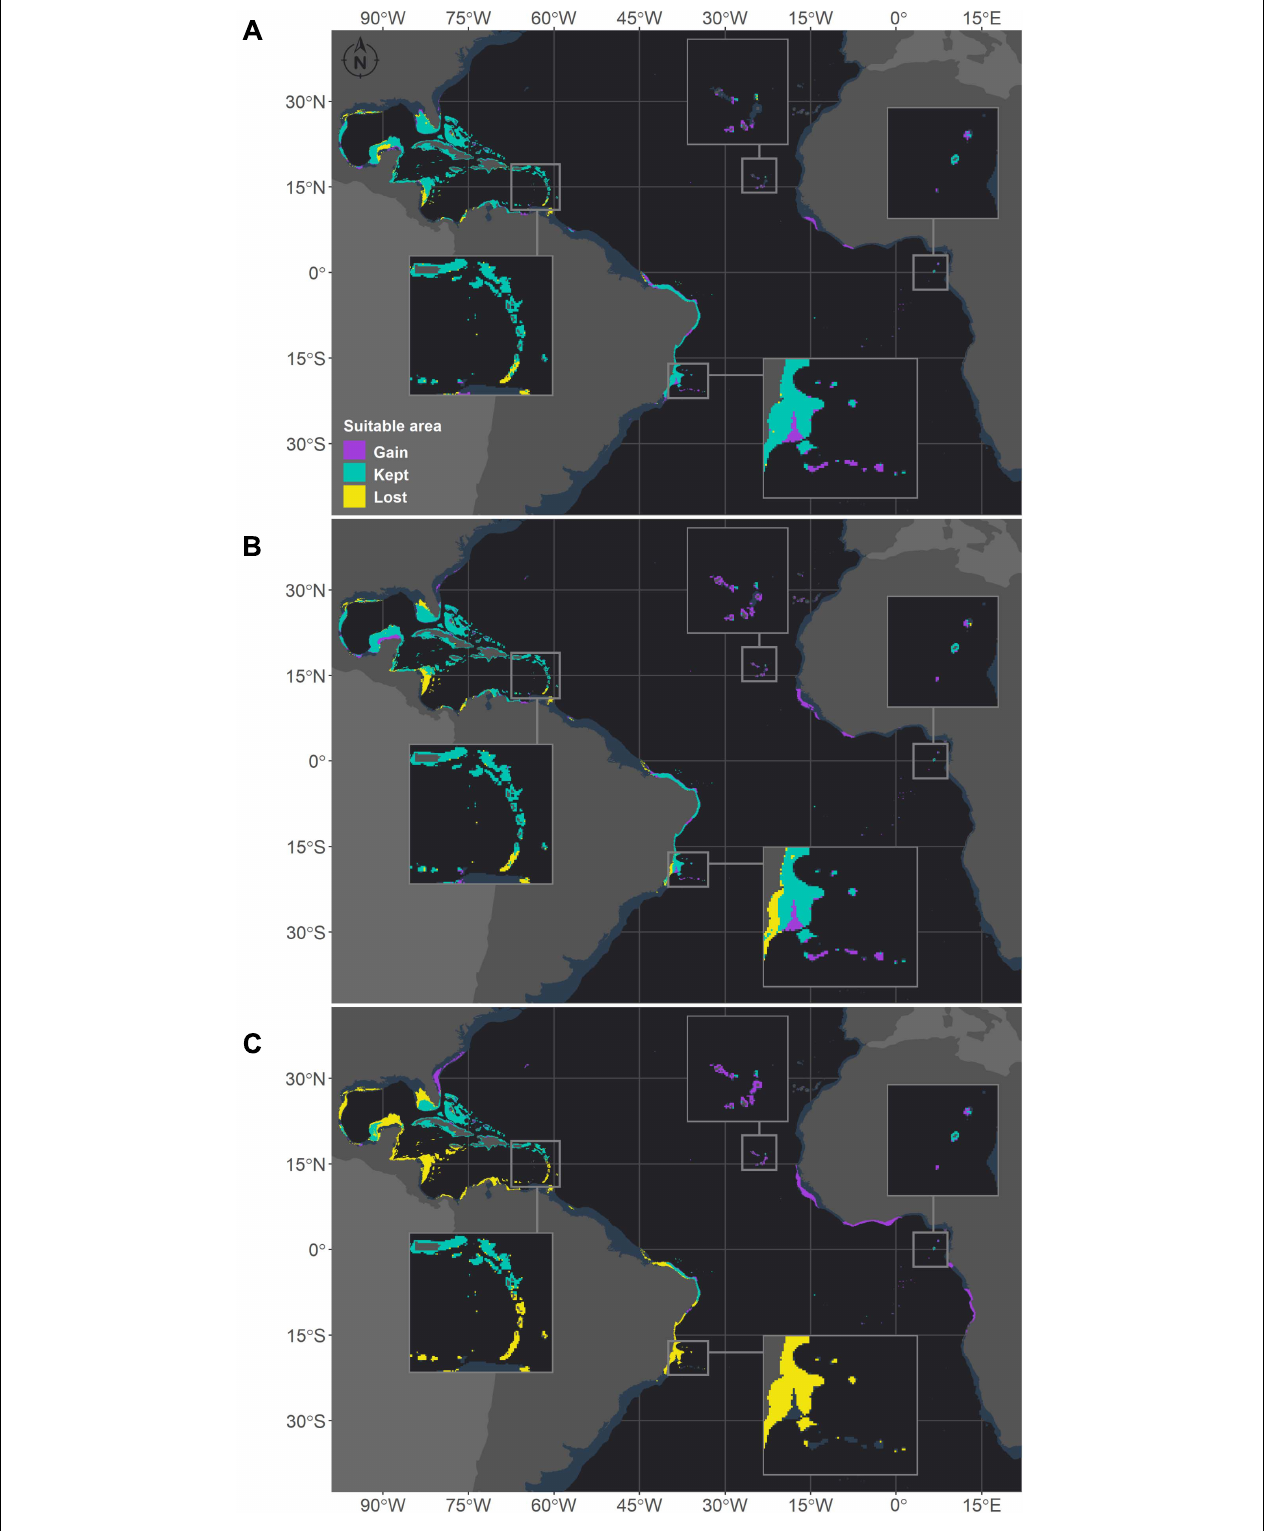
FIGURE 6 | Projected habitat suitability under future relative concentration pathway (RCP) scenarios for Siderastrea sp. in the Atlantic Ocean obtained through an ensemble modeling approach. The models were trained on present-day data of the species and projected for the (A) RCP2.6, (B) RCP4.5, and (C) RCP8.5 scenarios. Inset maps highlight changes in the Caribbean region (top left), Cape Verde islands (top), São Tomé islands (right) and Abrolhos region (bottom).